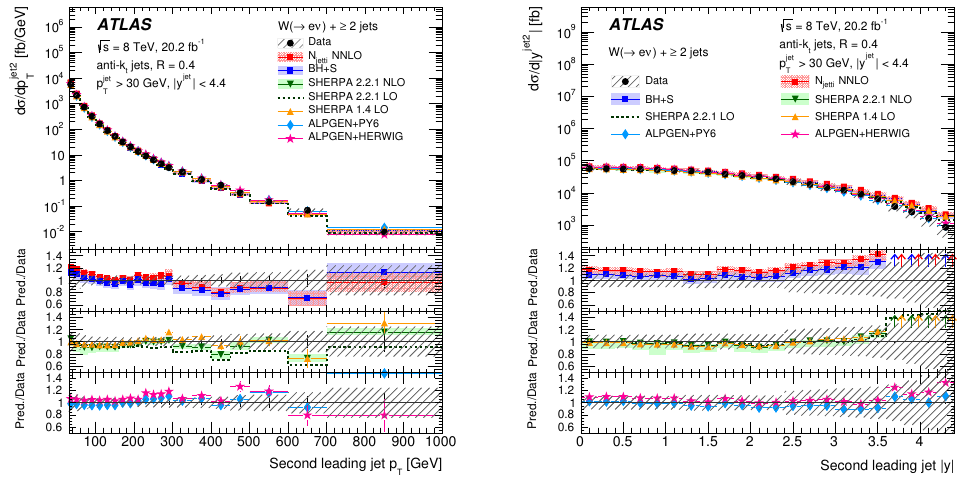
Figure 8 . Di(cid:11)erential cross sections for the production of W + jets as a function of second leading jet p T (left) and rapidity (right) for events with N jets (cid:21) 2. The last bin in the left (cid:12)gure includes values beyond the shown range. For the data, the statistical uncertainties are indicated as vertical bars, and the combined statistical and systematic uncertainties are shown by the hatched bands. The uppermost panel in each plot shows the di(cid:11)erential cross sections, while the lower panels show the ratios of the predictions to the data. The theoretical uncertainties on the predictions are described in the text. The arrows on the lower panels indicate points that are outside the displayed